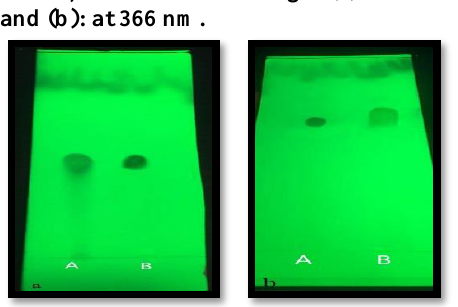
Figure10: Thin- layer chromatography for caffeic acid standard A and isolated caffeic acid B, detected under uv light (a): at 254 nm and (b): at 366 nm.